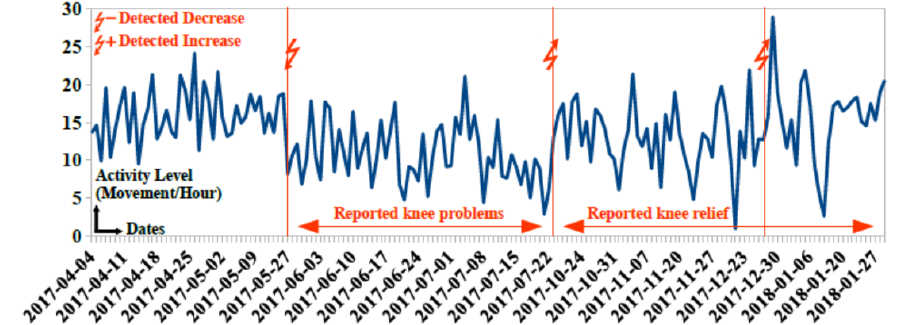
Figure 6. Detected changes in activity level of participant 99 due to knee